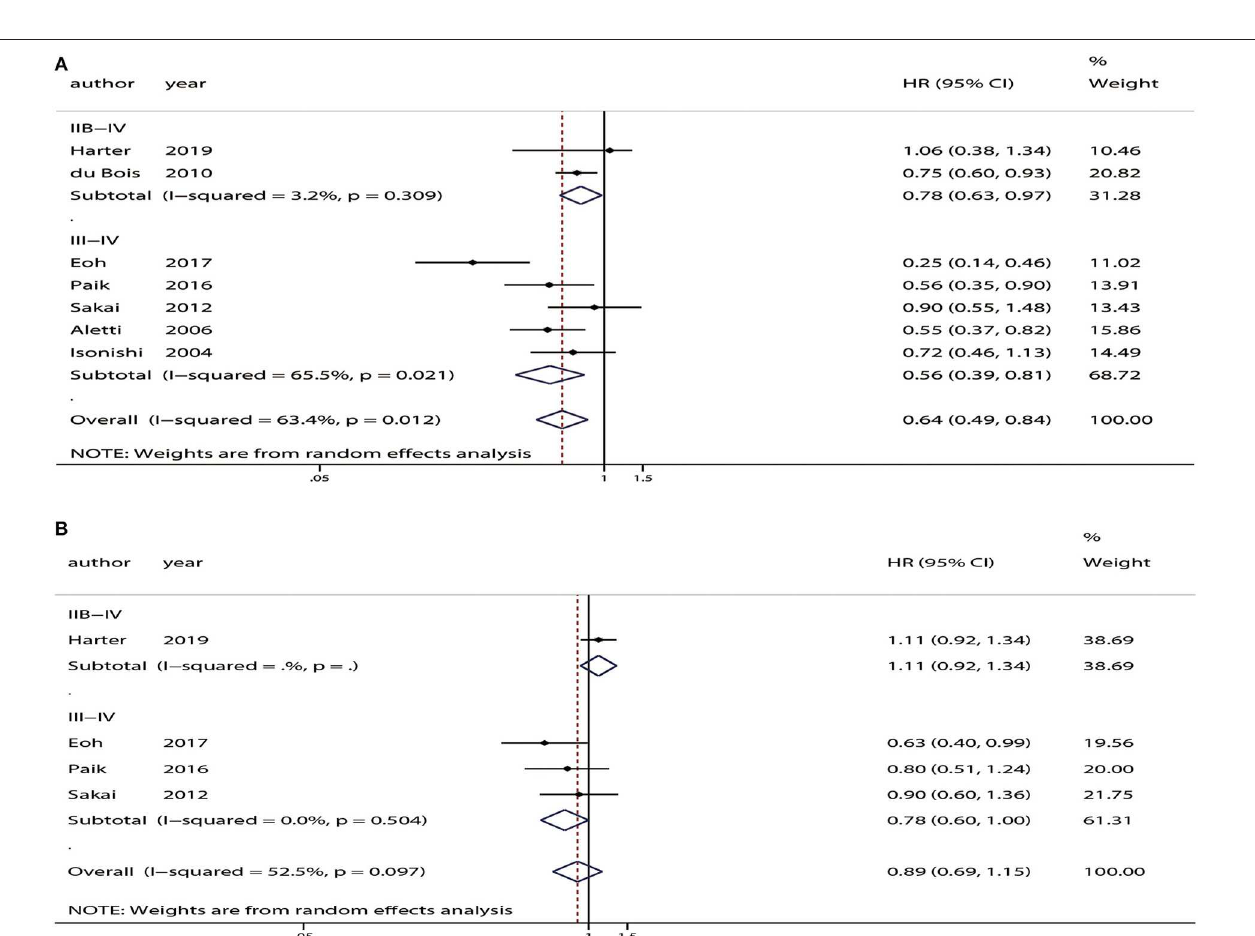
Frontiers in Oncology |